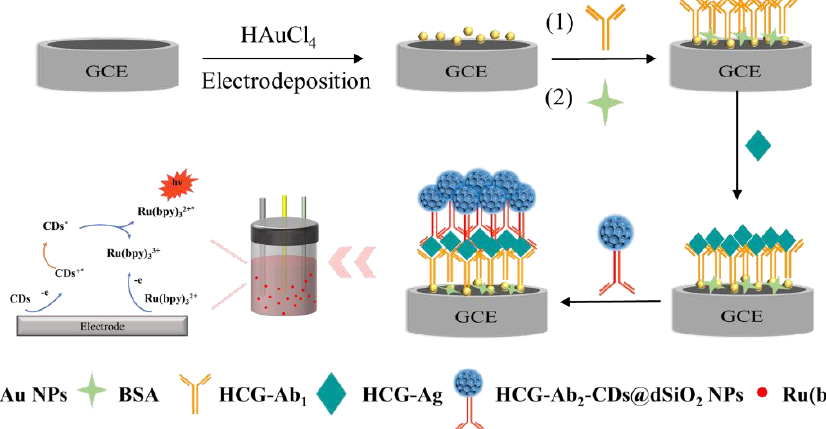
Figure 1. Schematic diagram of the preparation process and mechanism of the HCG immunosen- sor.